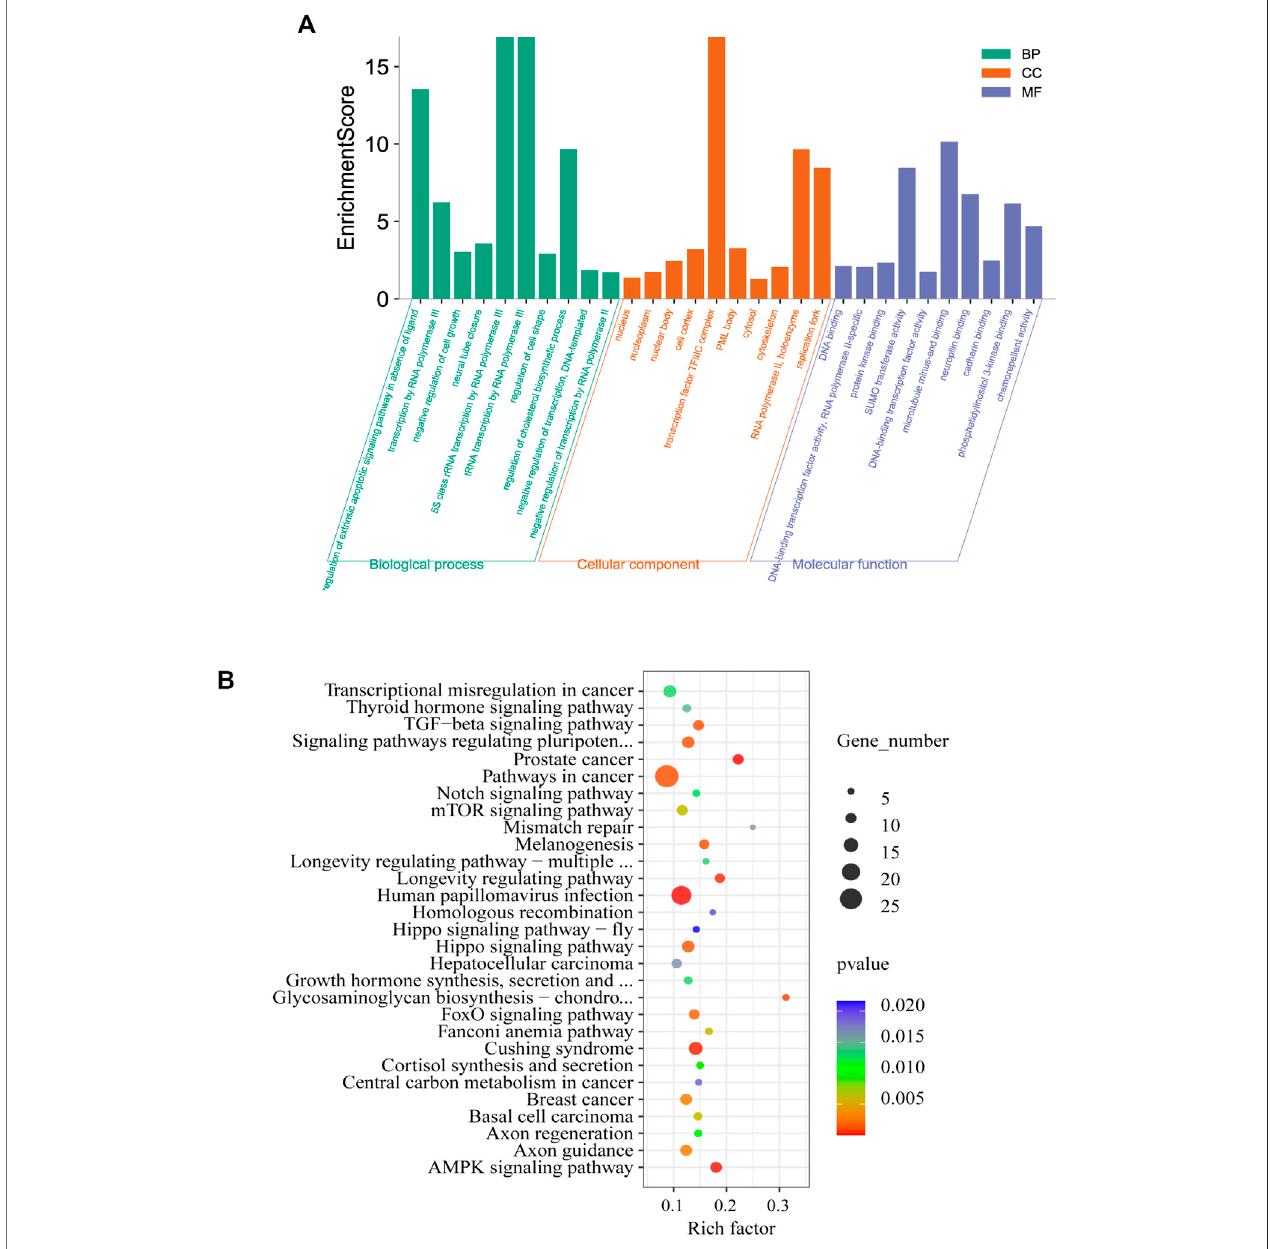
FIGURE 4 | Enrichment analysis. (A,B) , GO (A) and KEGG (B) analysis of genes associated with differential methylation peaks before and after sexual maturation.